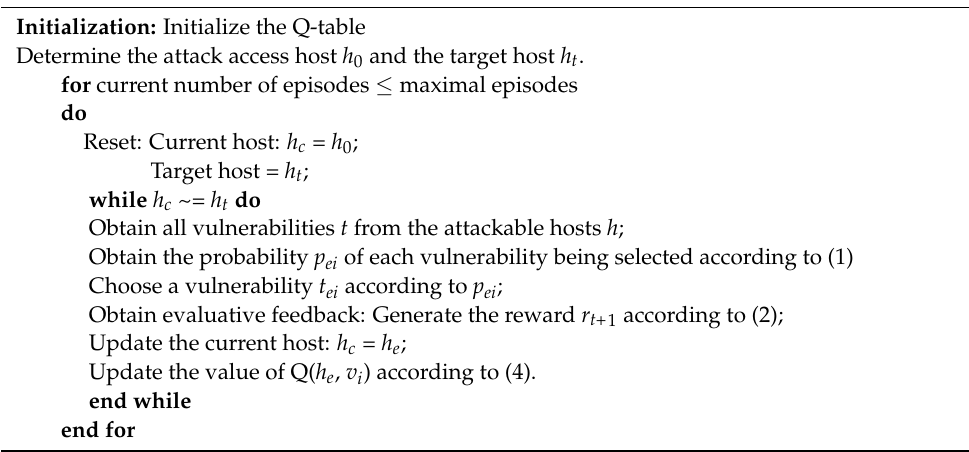
Algorithm 1 environment: FPN-Q Learning algorithm: learning